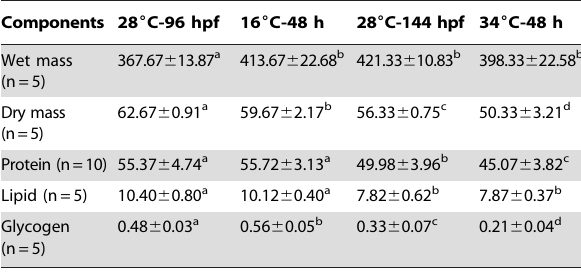
Table 1. Body composition of zebrafish larvae before and after temperature stress exposure.